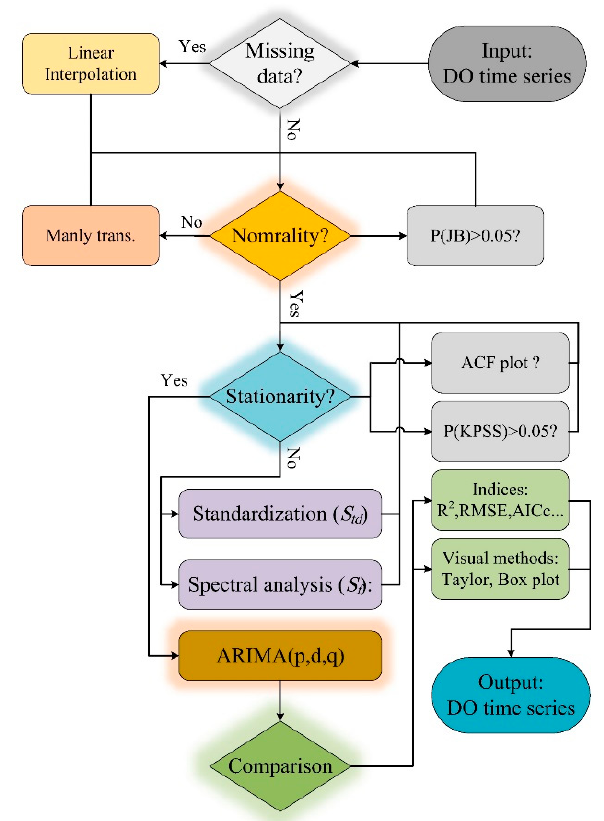
Figure 1. Flowchart of preprocessing and modeling procedure.